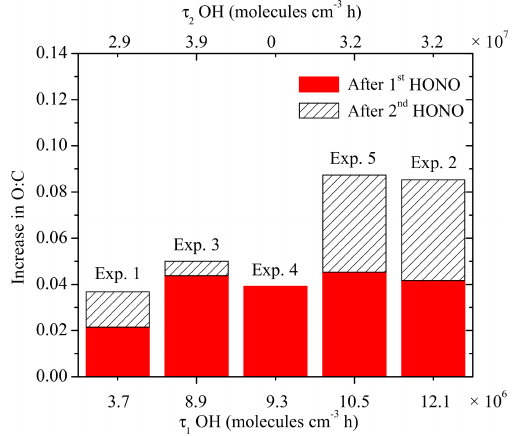
Figure 10. The absolute increase in O:C after the two doses of OH, with the corresponding exposure. The solid red columns are the increase in O:C after the first introduction of OH, with the cor- responding exposure on the bottom axis. The hatched columns are the increase in O:C after the second introduction of OH, with the corresponding exposure on the top